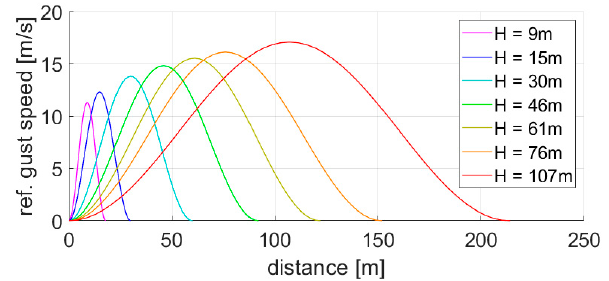
Figure 17. Overview of the 1-cos gust profiles.